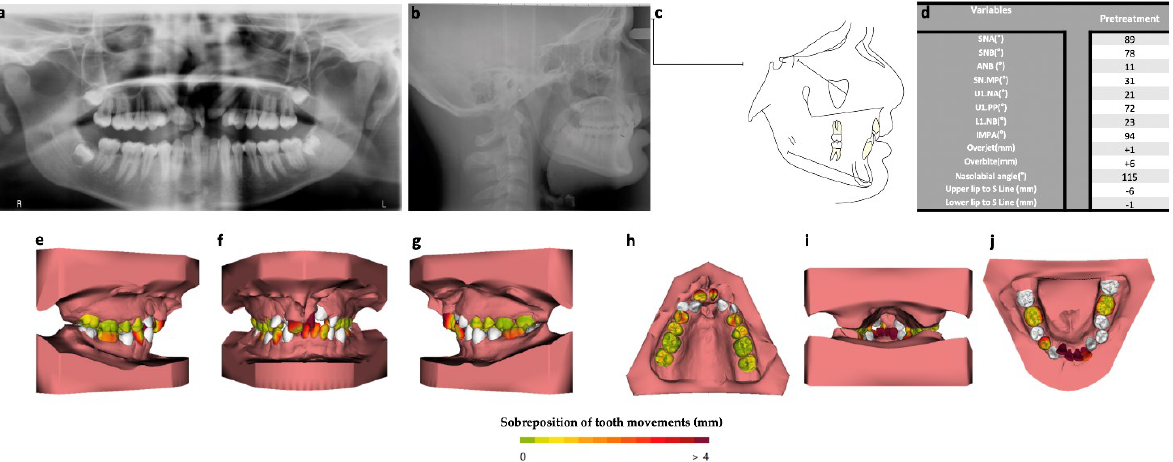
Figure 2. Pretreatment records: ( a ) orthopantomography; ( b ) lateral cephalogram; ( c ) cephalometric analysis; ( d ) dental casts; ( e ) right side; ( f ) frontal side; ( g ) left side; ( h ) superior arch; ( i ) back side; ( j ) inferior arch.